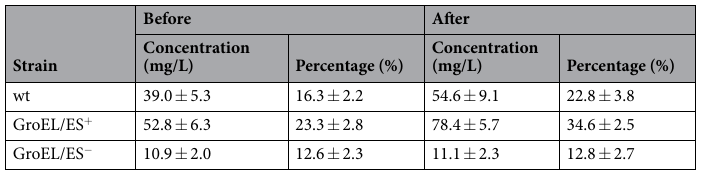
Table 1. Concentration and distribution of rhTRAIL between soluble and insoluble forms before and after in vivo